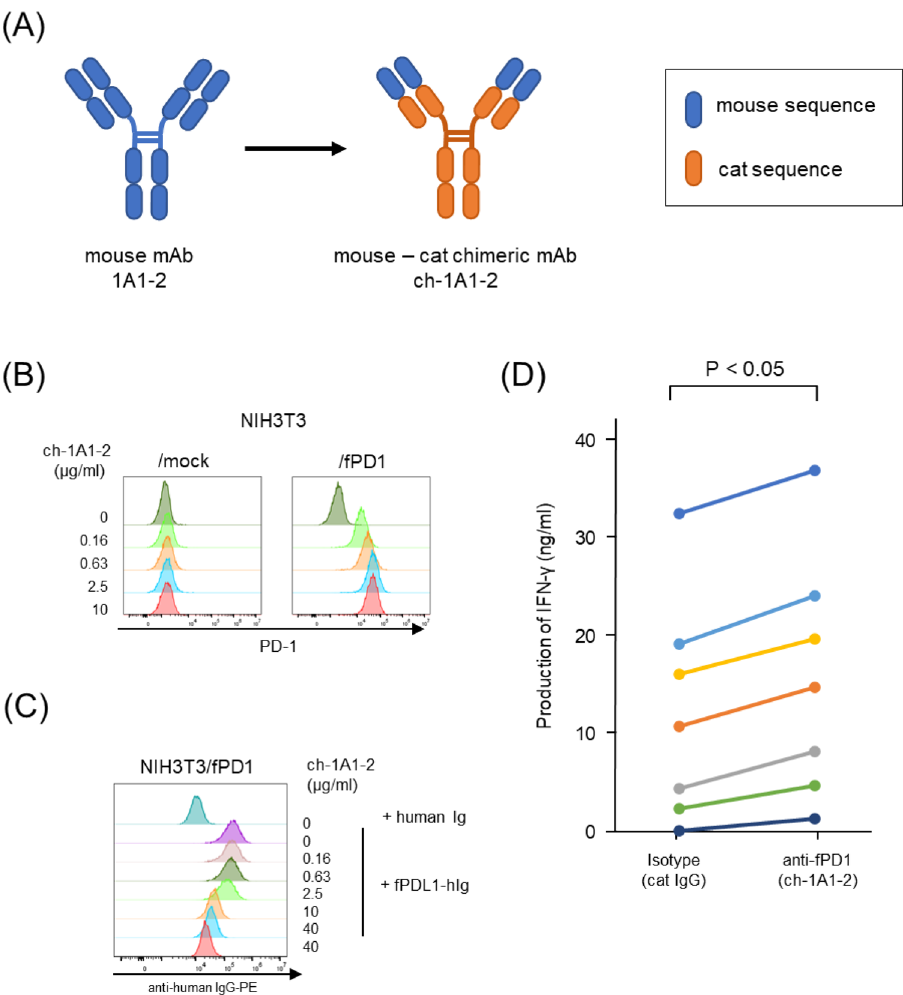
Figure 6. Generation of mouse-feline anti-PD-1 chimeric mAb and its functional analysis in vitro . ( A ) Schematic overview of mouse mAb, 1A1-2, and mouse-feline chimeric mAb, ch-1A1-2. The portions derived of mouse sequence are indicated by blue diagrams, and those of cat sequence are indicated by orange diagrams. ( B ) NIH3T3 or mock and NIH3T3/fPD1 or NIH3T3/fPD1 were stained with dose-titrated ch-1A1-2 followed by staining with a secondary anti-cat IgG-PE antibody. ( C ) NIH3T3/fPD1 cells were preincubated with dose- titrated ch-1A1-2, and, after washing, incubated with 1 μg/mL of fPDL1-hIg or human Ig. Cells were then stained with a secondary antibody anti-human IgG-PE. ( D ) PBLs were isolated from seven healthy cats and stimulated with 10 µg/mL of concanavalin A (Con A) for 48 h in the presence of a cat IgG isotype control or anti-fPD1 (ch-1A1-2). After 48 h, the culture supernatant was collected and the amount of feline IFN-γ was measured in duplicate. Different color bars indicate different